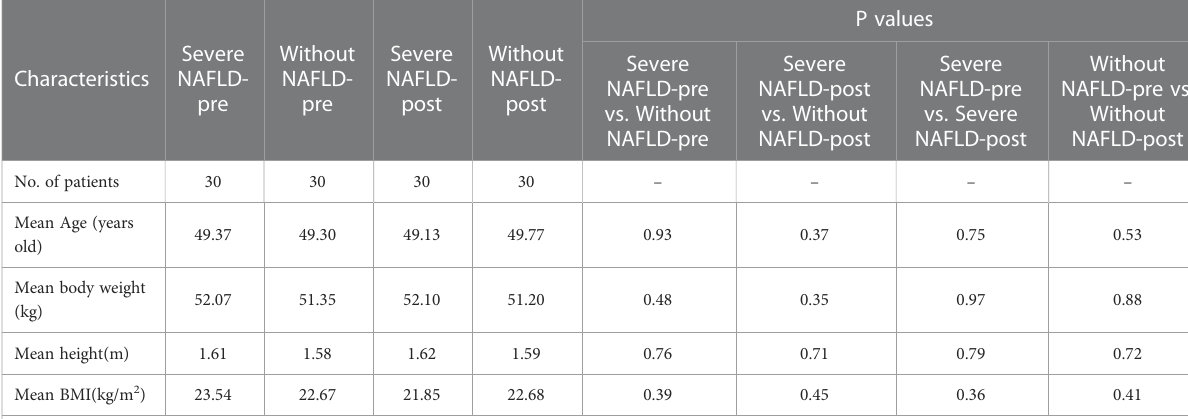
TABLE 1 Clinicopathologic characteristics of 120 patients in the fi rst cohort.